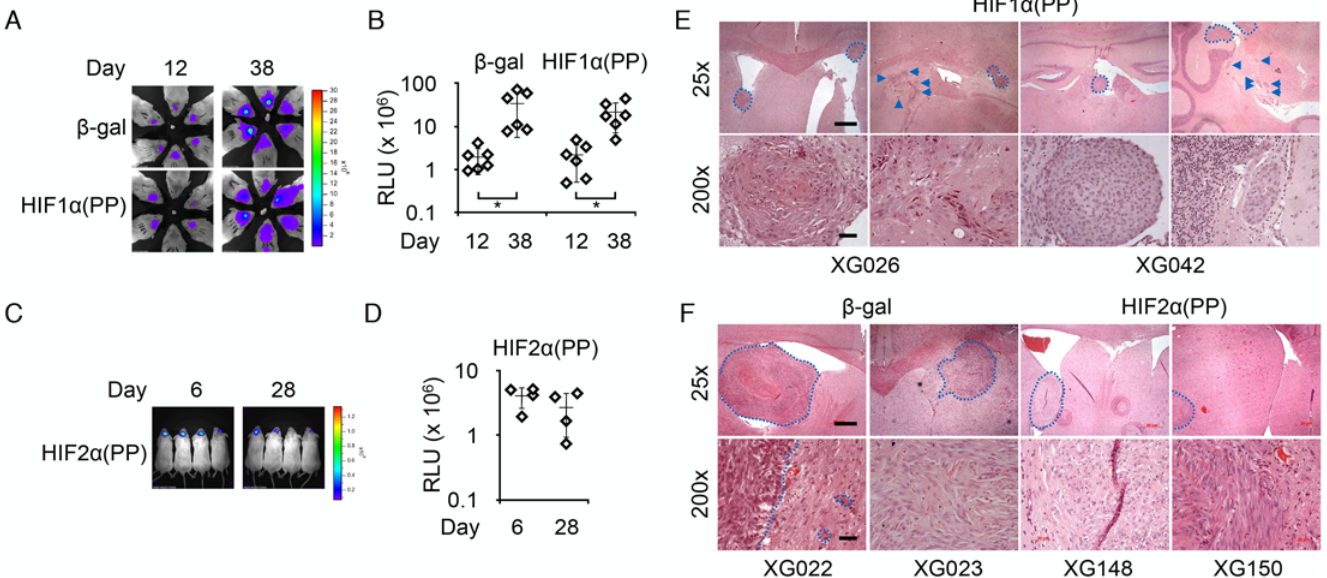
Fig 4. Intermittent induction of HIF1 α (PP) promoted intracranial spread of U-87 MG cells. Bioluminescent imaging analysis of β -gal and HIF1 α (PP)- derived intracranial tumors (A) and HIF2 α (PP)-derived intracranial tumors (C). The respective tumor volumes were calculated based on the relative luminescent units (RLU) and plotted in a log scale (B and D). * , p -value < 0.05. (E) HIF1 α (PP)-derived tumors had small yet numerous lesions invading the Ammon ’ s horn of the hippocampal region (XG026) and hindbrain and cerebellum (XG042), as indicated by arrowheads. (F) β -gal- and HIF2 α (PP)-derived tumors were large and often singular in the cerebral cortex. Tumor lesions are demarcated in dash lines. Hematoxylin and eosin — stained images are presented at 25× and 200× magnifications, with scale bars of 1 mm and 100 μ m, respectively.